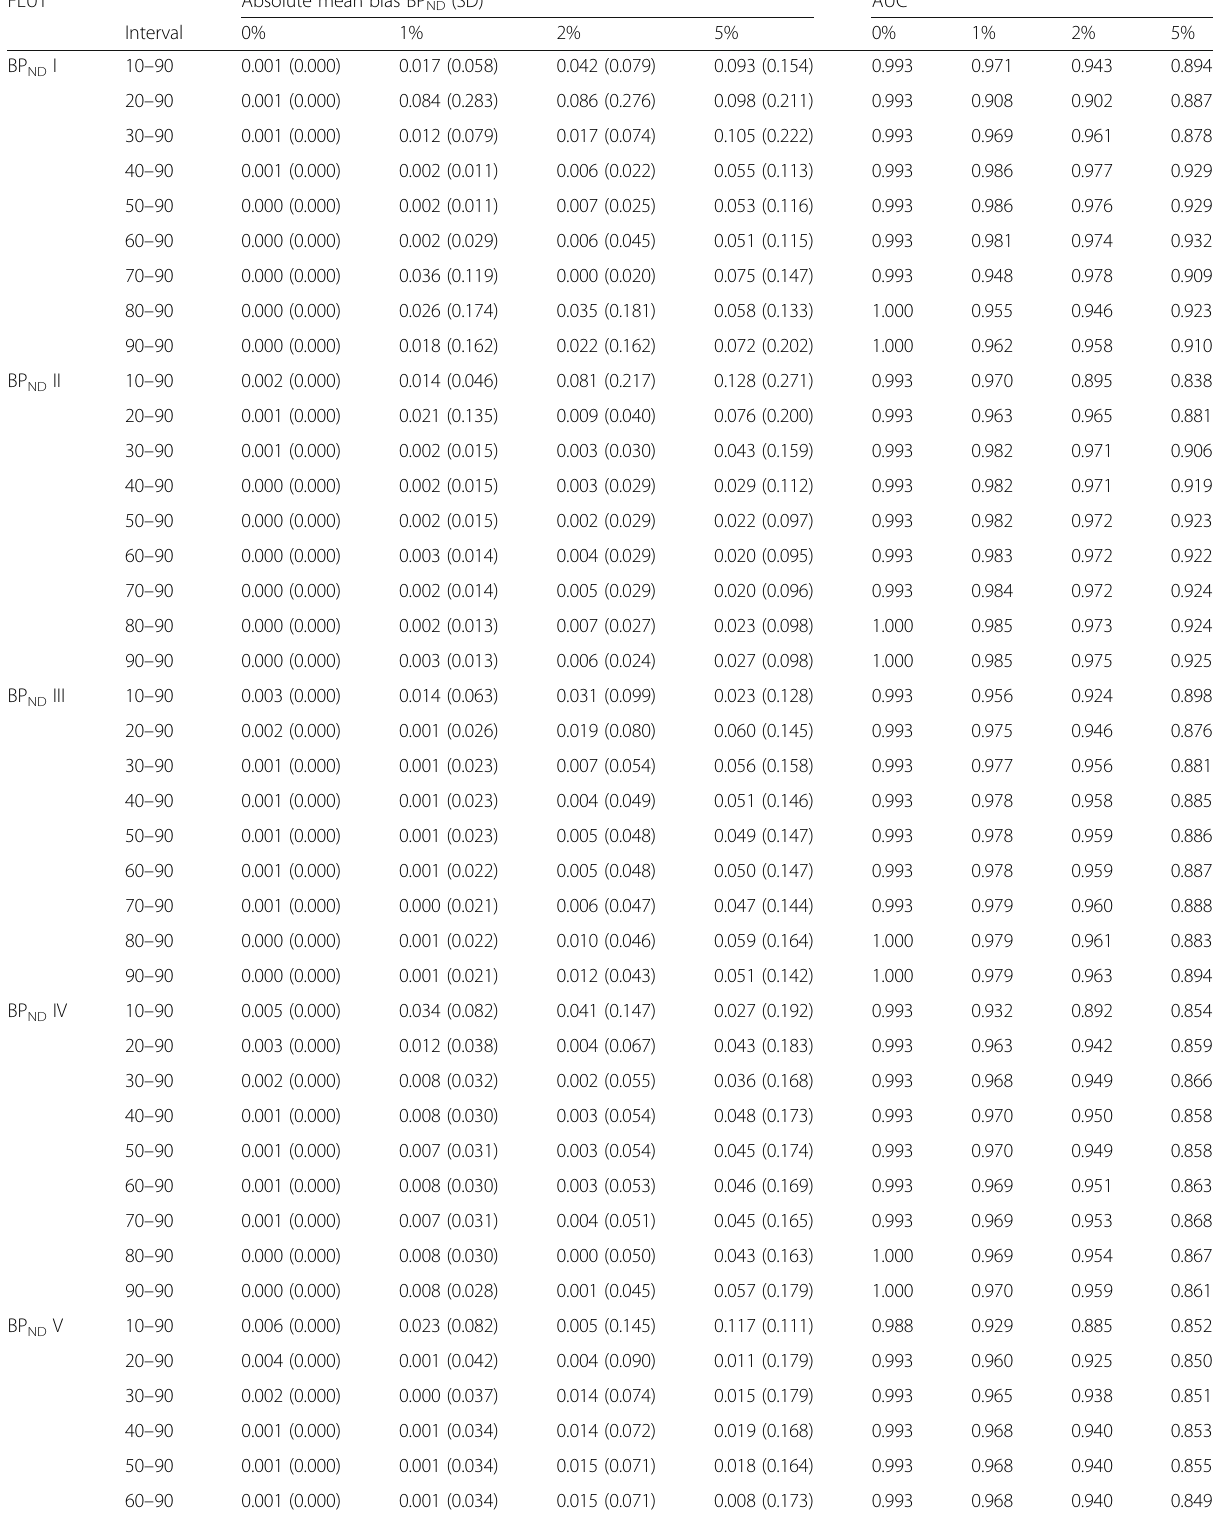
Table 5 Absolute bias in BP ND and AUC as a result of noise and the dual-time-window protocol for